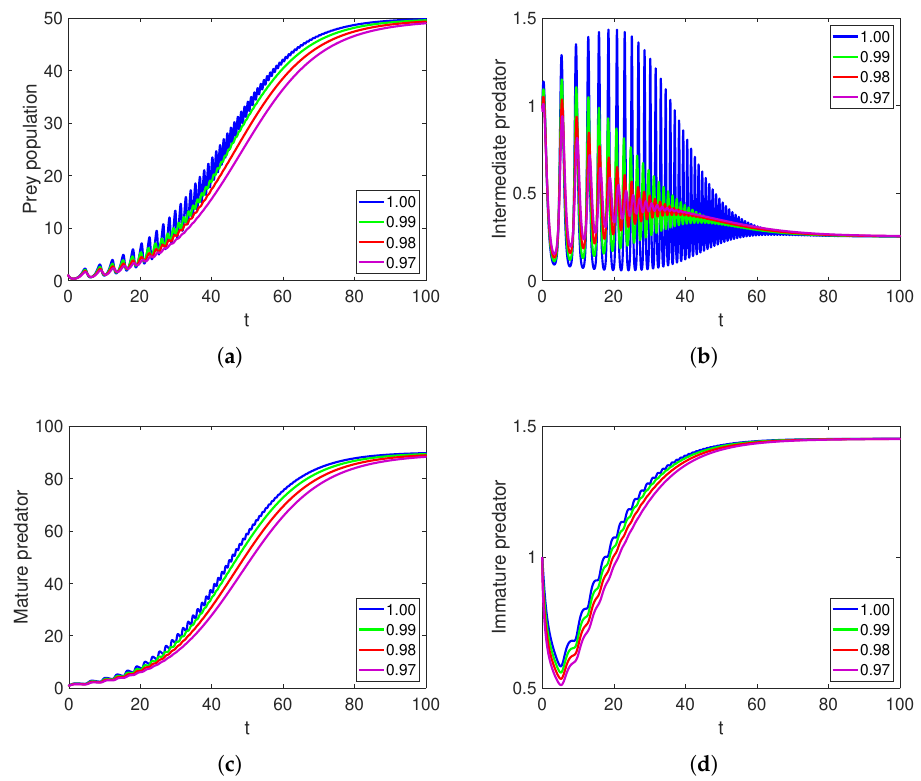
Figure 2. The dynamics of different classes of model (2) with different fractional orders vs. t .